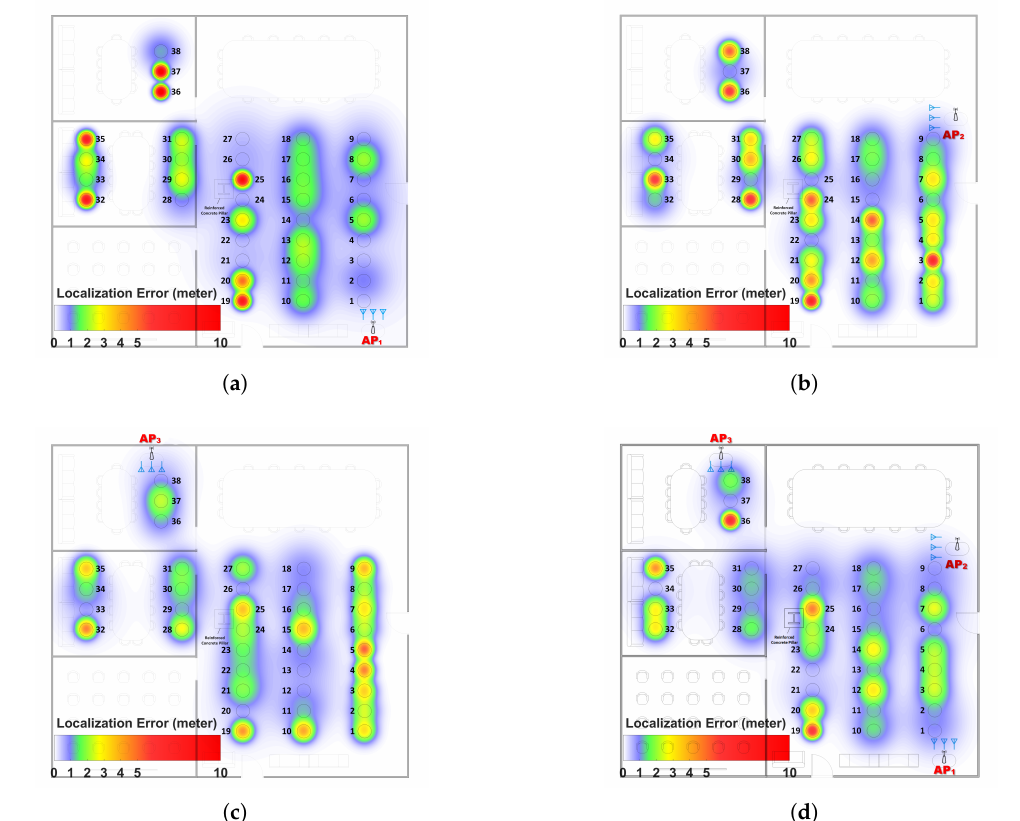
Figure 11. Localization error heat map of ( a ) AP 1 , ( b ) AP 2 , and ( c ) AP 3 and ( d ) the multi-AP adaptive method. The blue symbols show the orientation of the antenna